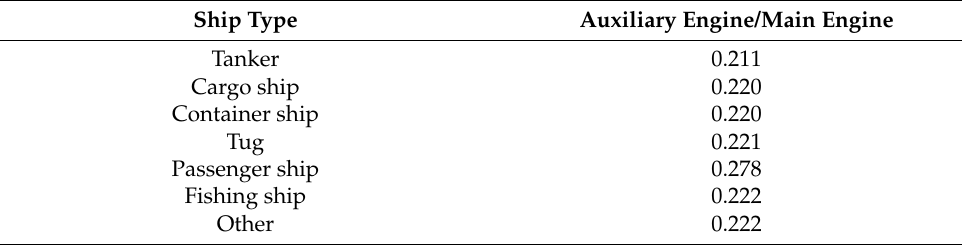
Table 6. Power ratios of